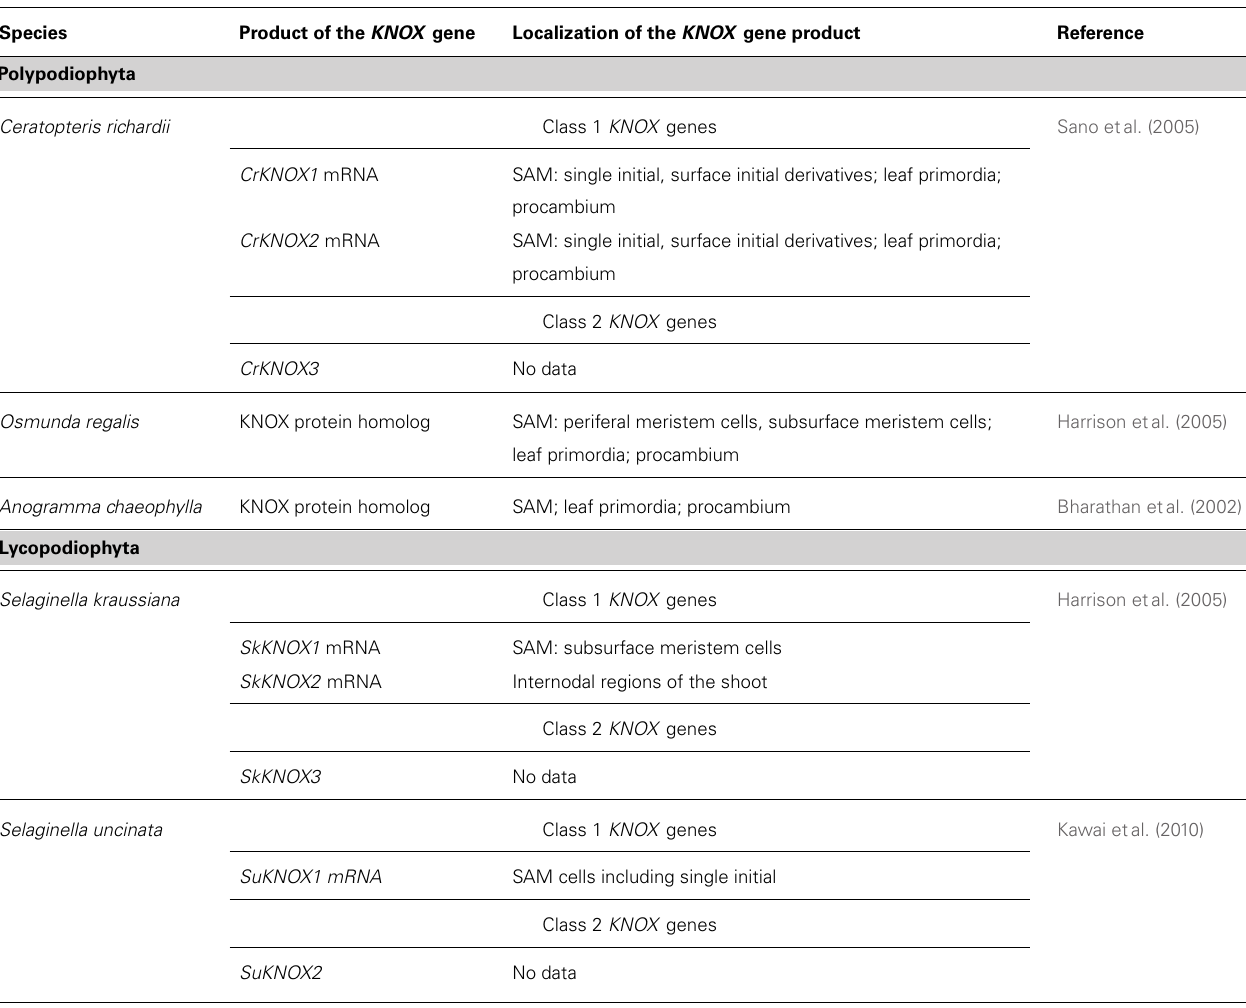
Table 1 | Localization on KNOX gene products (mRNA, proteins) in seedless vascular